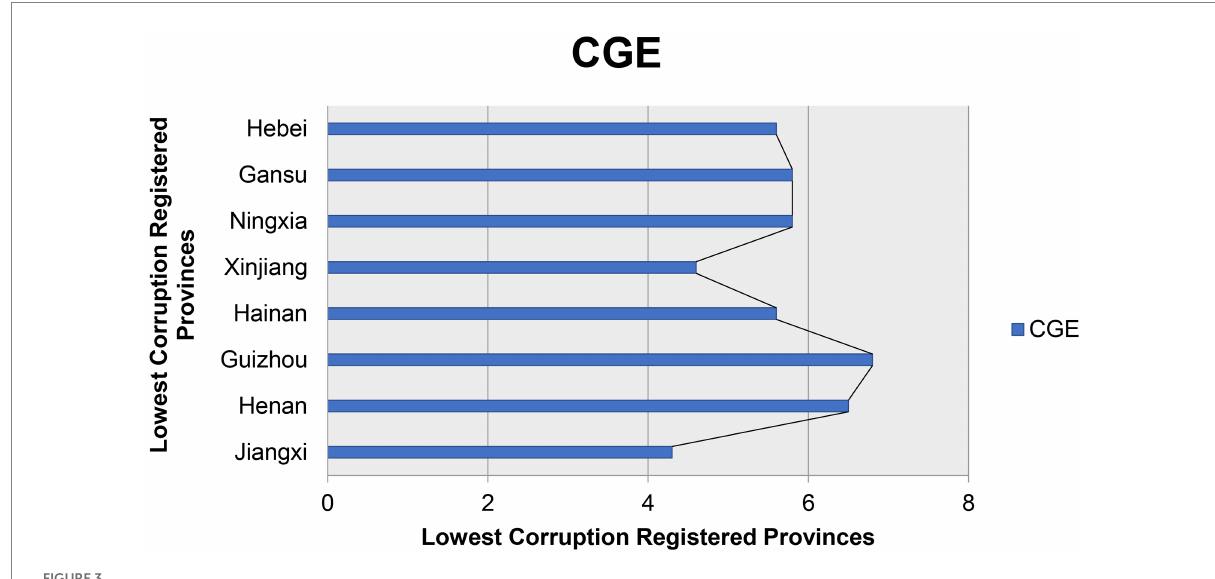
FIGURE 3 Lowest corruption registered provinces.